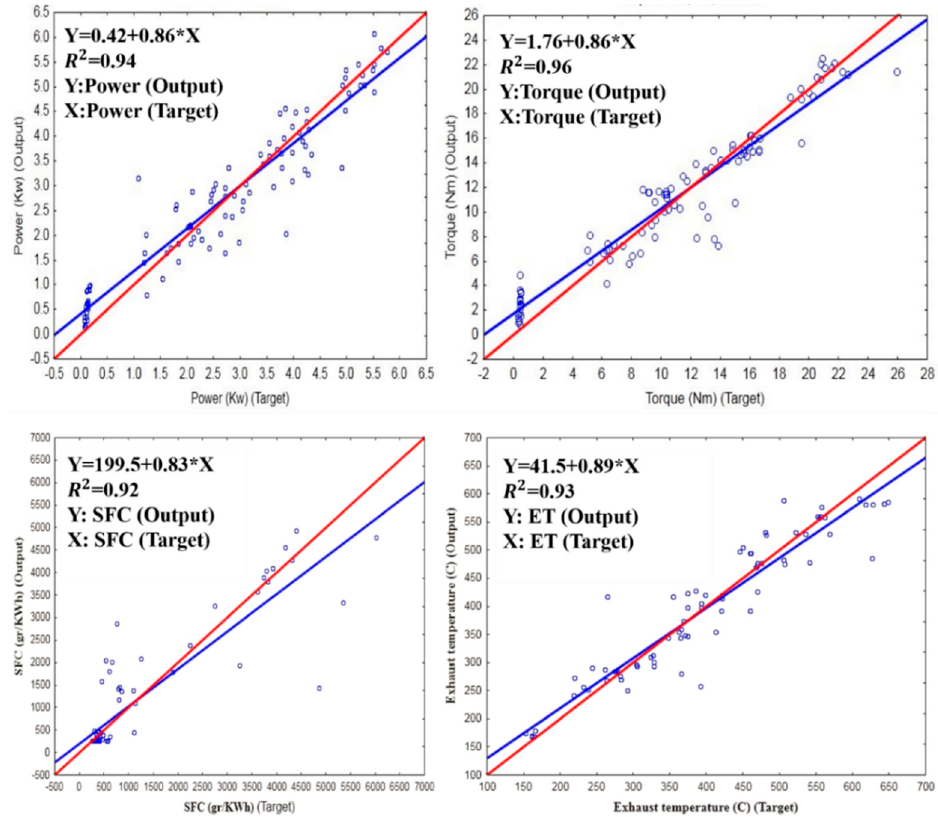
Figure 22. The predicted outputs vs. the measured values for engine performance parameters (Y: Output of the model; X: Target or experimental data, Red line: 45 degree line e.g., Y = X, Blue line: Fitted line).